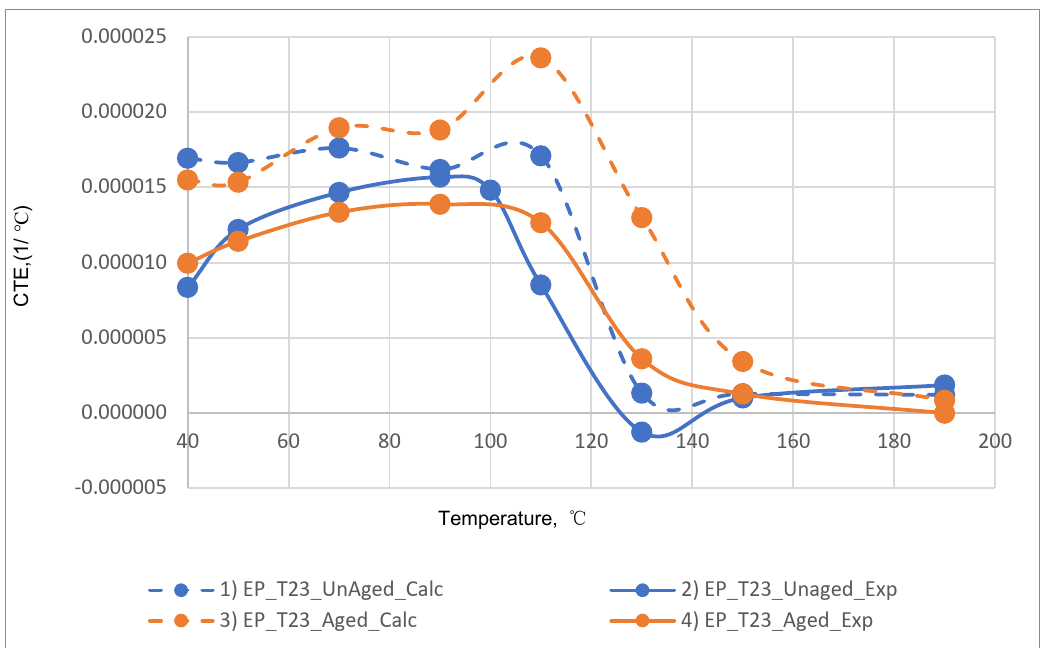
Figure 16. Dependence of CTE on temperature for epoxy fiberglass on fiberglass fabric T-23: (1) calculated for EP-T23; (2) experimental for EP-T23; (3) calculated for EP-T23-TA; (4) experimental for EP-T23-TA.